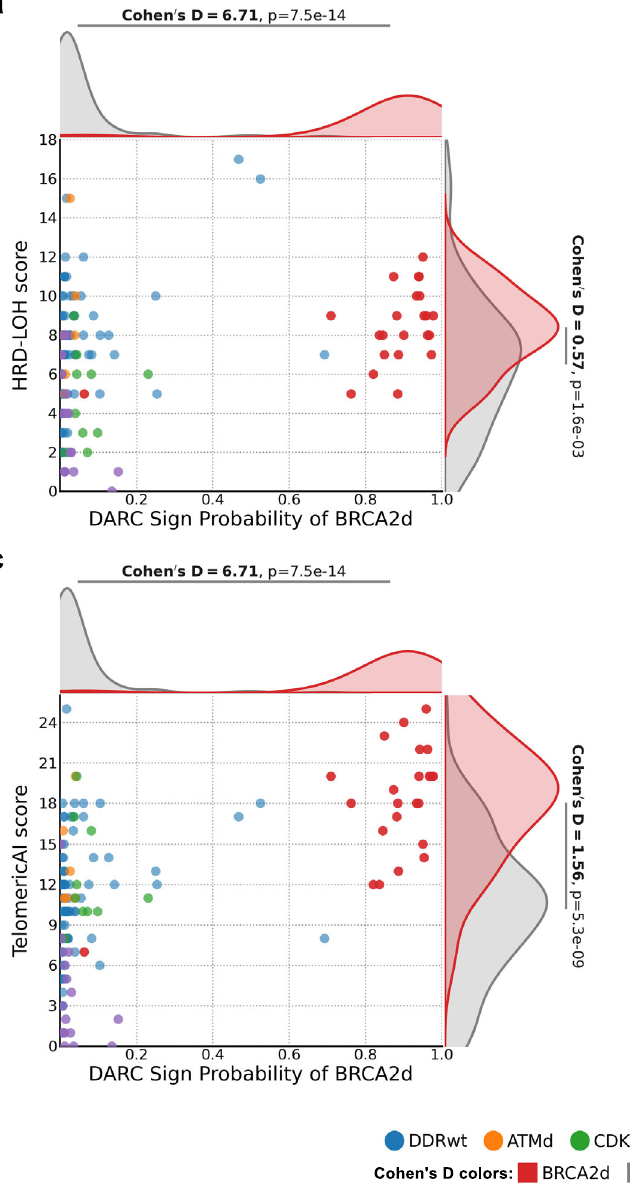
Fig. 5 ScarHRD values compared to DARC sign BRCA2d probabilities. a Homologous Recombination De fi ciency - Loss of Heterozygosity (HRD-LOH) score: the number of regions greater than 15 Mb (but not covering the entire chromosome) that show LOH. b Large Scale Transition (LST) score: the number of chromosomal breaks between adjacent regions of at least 10 Mb, with a distance between them not larger than 3 Mb. c Telomeric Allelic Imbalances (TelomericAI) score, the number of allelic imbalances that extend to the telomeric end of